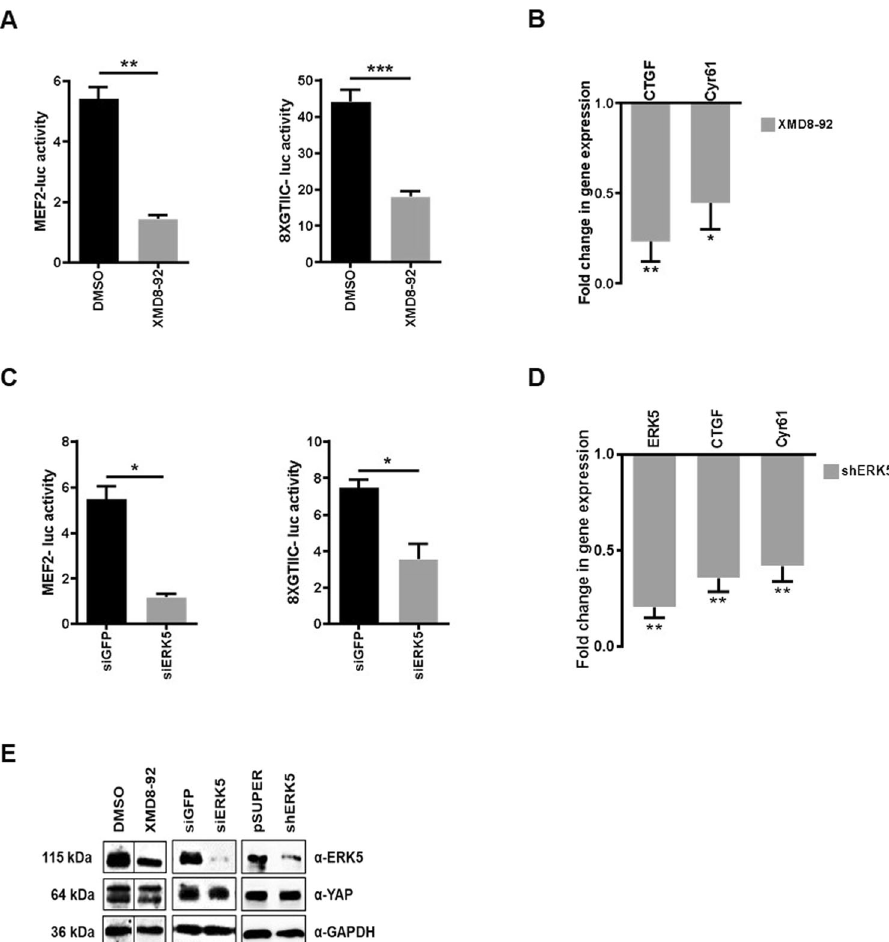
Fig. 2 ERK5 is required for the steady-state YAP transcriptional activity. A Luciferase assay. MEF2-luc or 8xGTIIC-luc reporters were transiently co-transfected in RLSCs, together with a Renilla expression vector. Luciferase activities were normalized for Renilla luciferase activity and expressed as arbitrary units. Twenty-four hours post-transfection, cells were treated with 10 µM XMD8-92 or its solvent DMSO for 16 h. Statistically signi fi cant differences are reported (** p < 0.01; *** p < 0.001). B RT-qPCR analysis of the indicated genes in RLSCs treated with XMD8-92 or DMSO. The values are calculated by the 2( − Δ Ct) method, expressed as fold change in gene expression versus the control (DMSO, arbitrary value = 1) and shown as means ± S.E.M. of at least three independent experiments. Statistically signi fi cant differences are reported (* p < 0.05; ** p < 0.01). C Luciferase assay. MEF2-luc or 8xGTIIC-luc reporters were transiently co-transfected in RLSCs, together with a Renilla expression vector and siERK5 or siGFP. Luciferase activities were normalized for Renilla luciferase activity and expressed as arbitrary